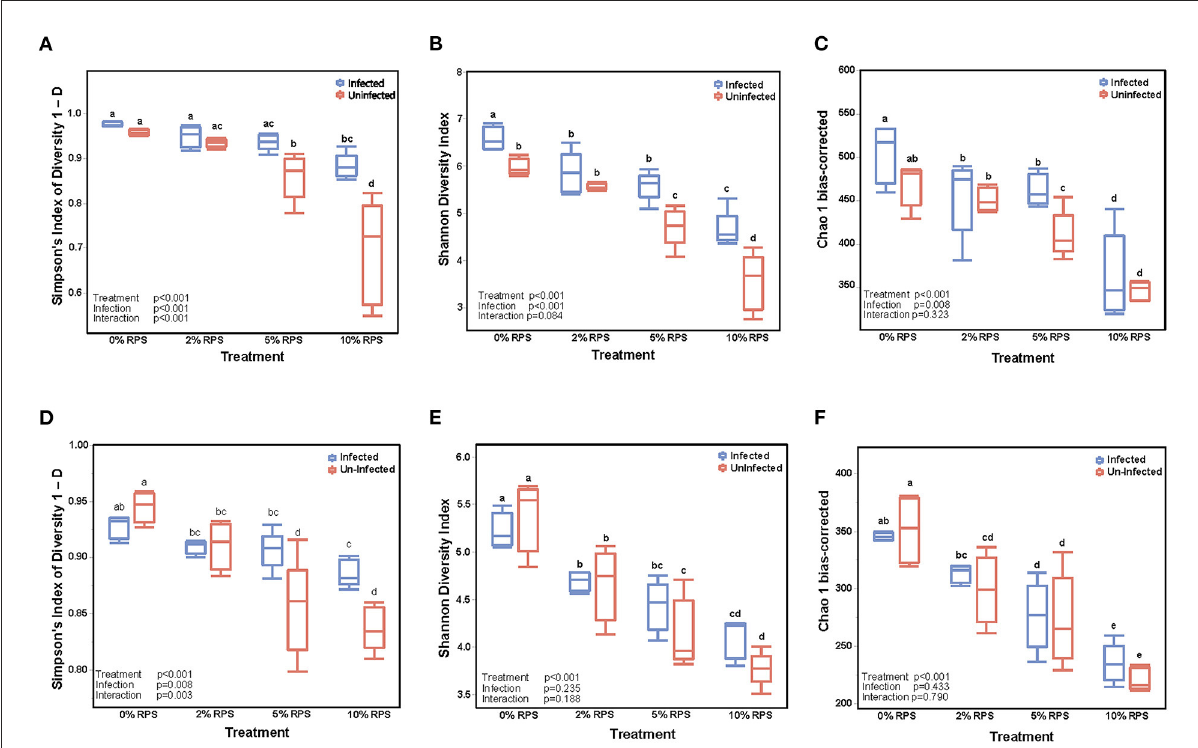
FIGURE3 Feeding RPS decreases the α -diversity of fecal and cecal microbiomes and the relative abundance of genera and this is partially reversed by Cr infection. α -diversity was determined on cecal samples collected at 12 days post-infection (A–C) and on fecal samples collected 6 days post-infection (D–F). n = 4–5/group. Groups with different letters are significantly different, p < 0.05.